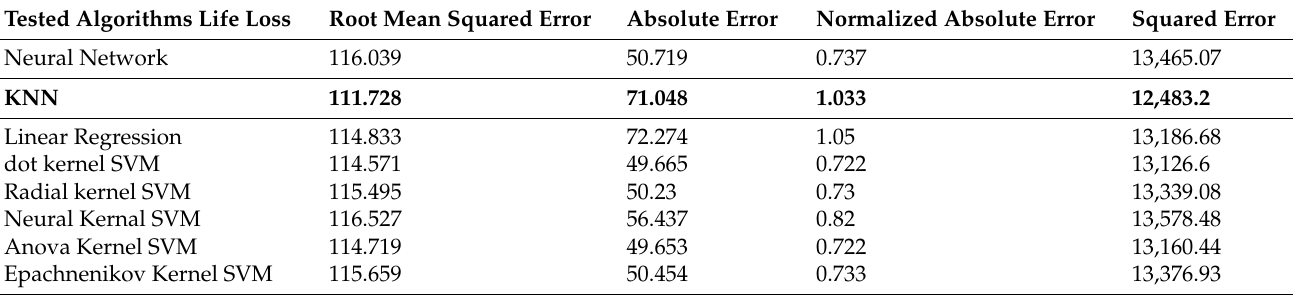
Table 4. Life loss algorithms comparative results.